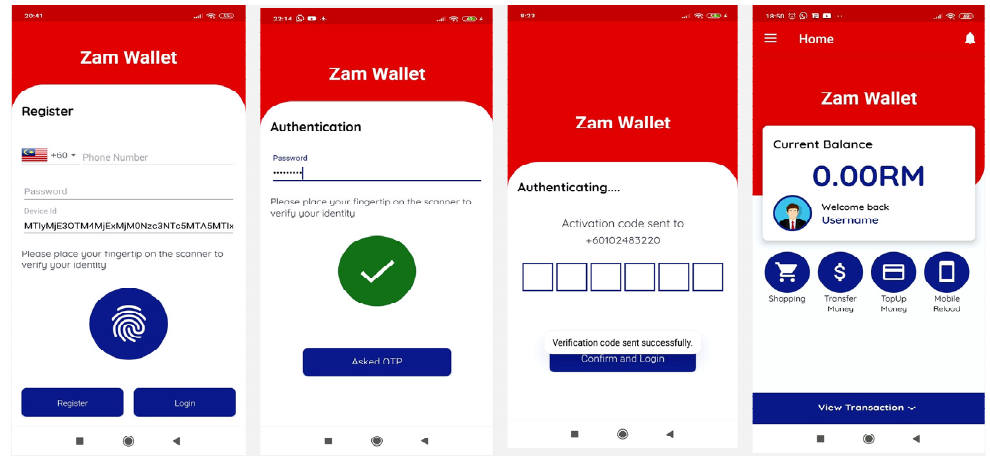
Figure 12. Login process of Zamwallet.